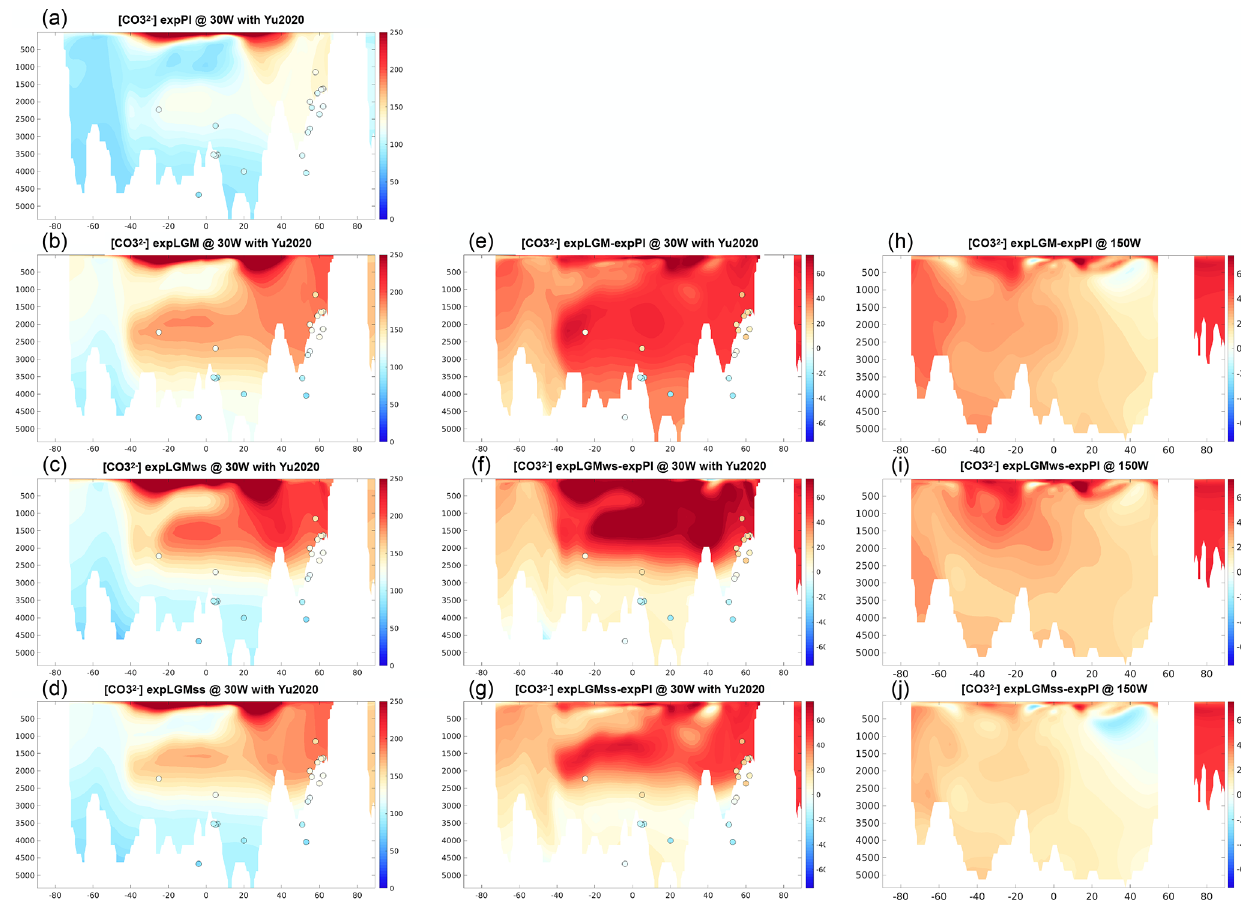
Figure 9. Meridional sections in the Atlantic ( a–g ; at 30 ◦ W) and in the Pacific ( h–j ; at 150 ◦ W) of the simulated carbonate ion concentrations (mmolm − 3 ). The absolute values for (a) expPI, (b) expLGM, (c) expLGMws, and (d) expLGMss and the differences between each LGM experiment and expPI are shown (e–j) . The dots indicate the reconstruction by Yu et al. (2020). The average states of the last 50 years are